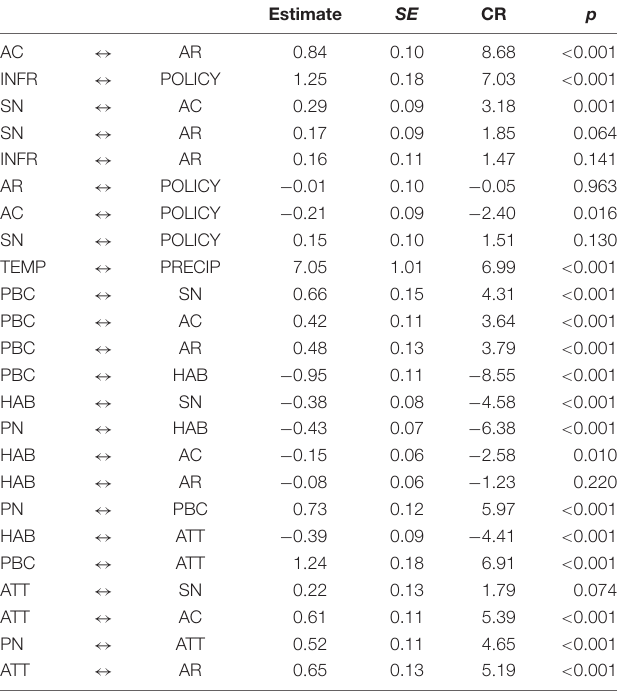
TABLE 4 | Specified covariance in the structural